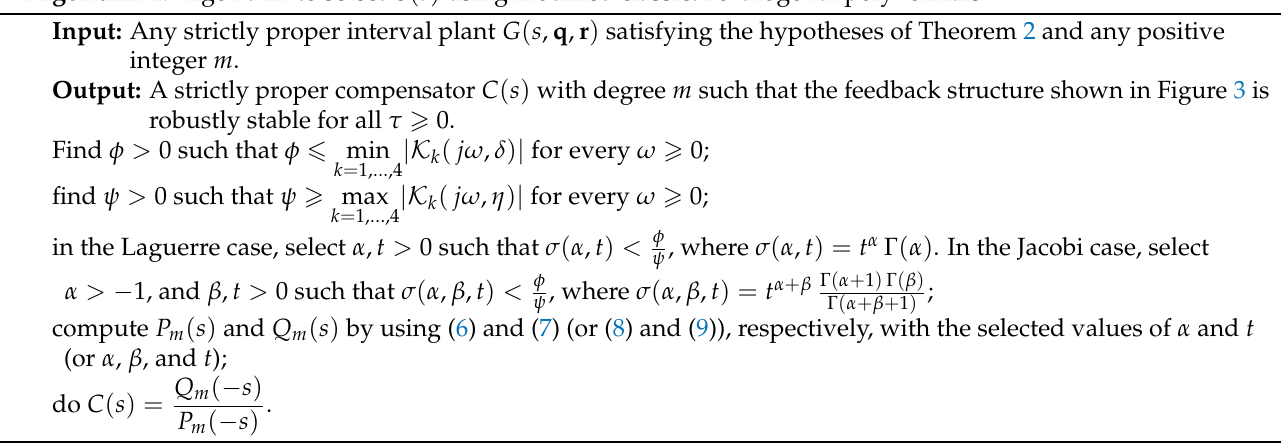
Algorithm 1: Algorithm to select C ( s ) using modified classical orthogonal